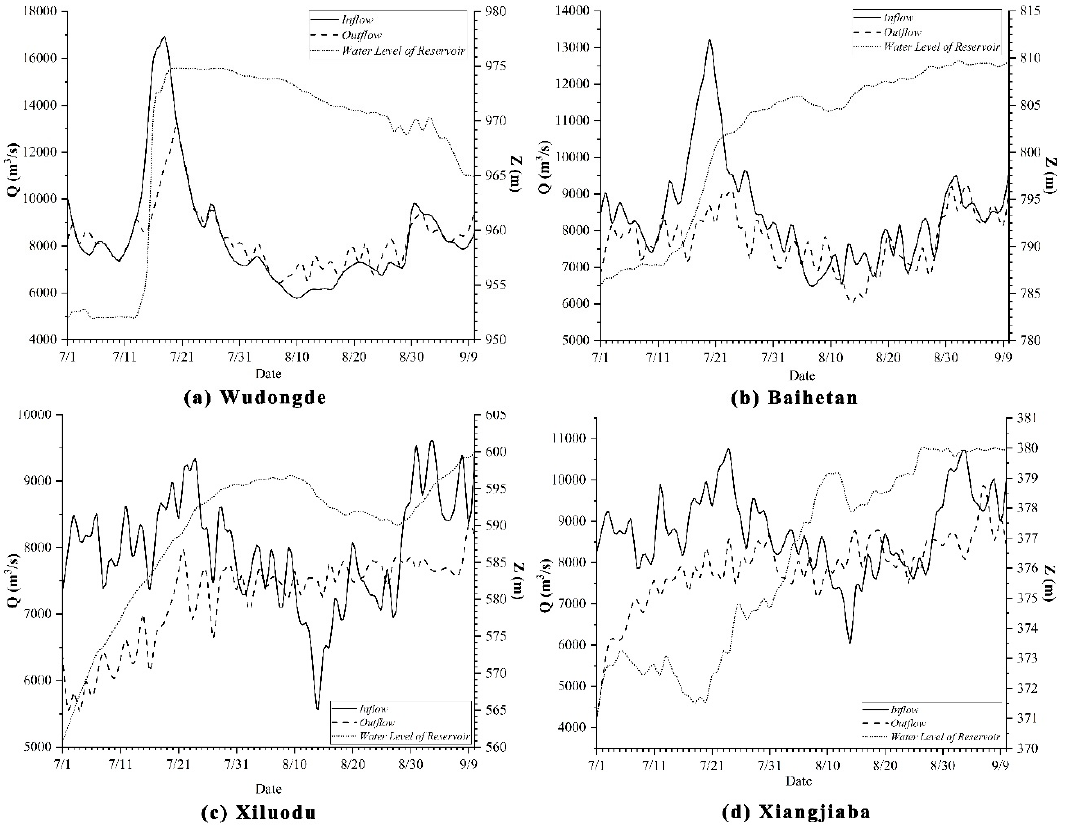
Figure 10. The cascade scheduling results under the optimal scheme to best satisfy the constraints.